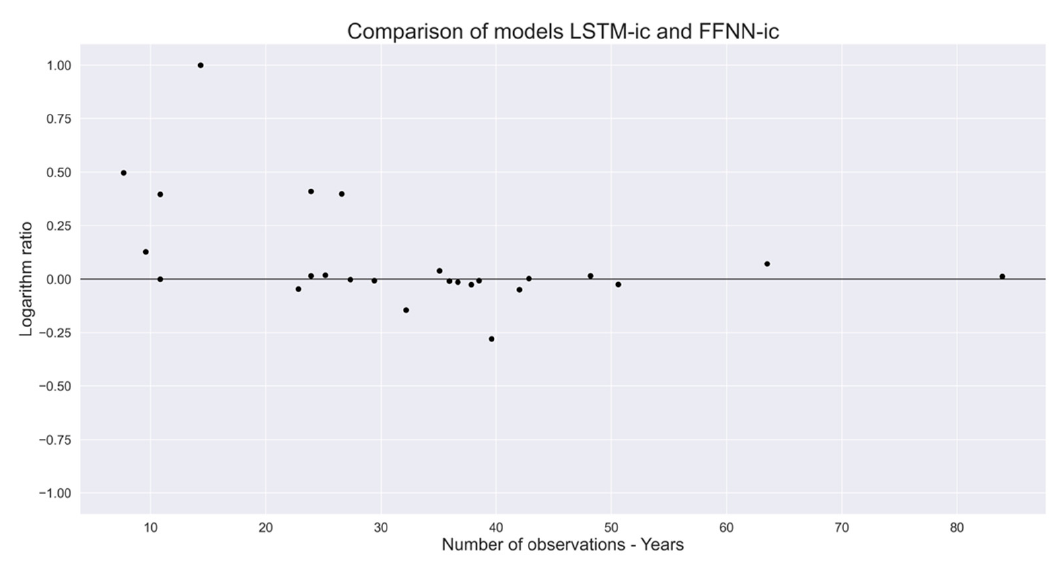
Figure 7. The y-axis represents the logarithm of the ratio of the NSE index of the LSTM-ic over the NSE from the FFNN-ic model against the number of data observations in years in each basin (x-axis).